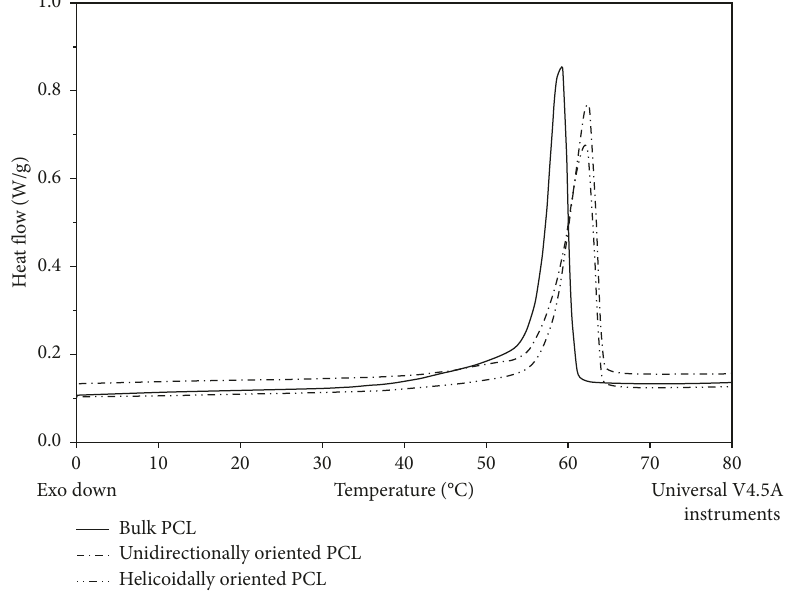
Figure 6: DSC scans of bulk, helicoidal, and unidirectionally oriented PCL samples.